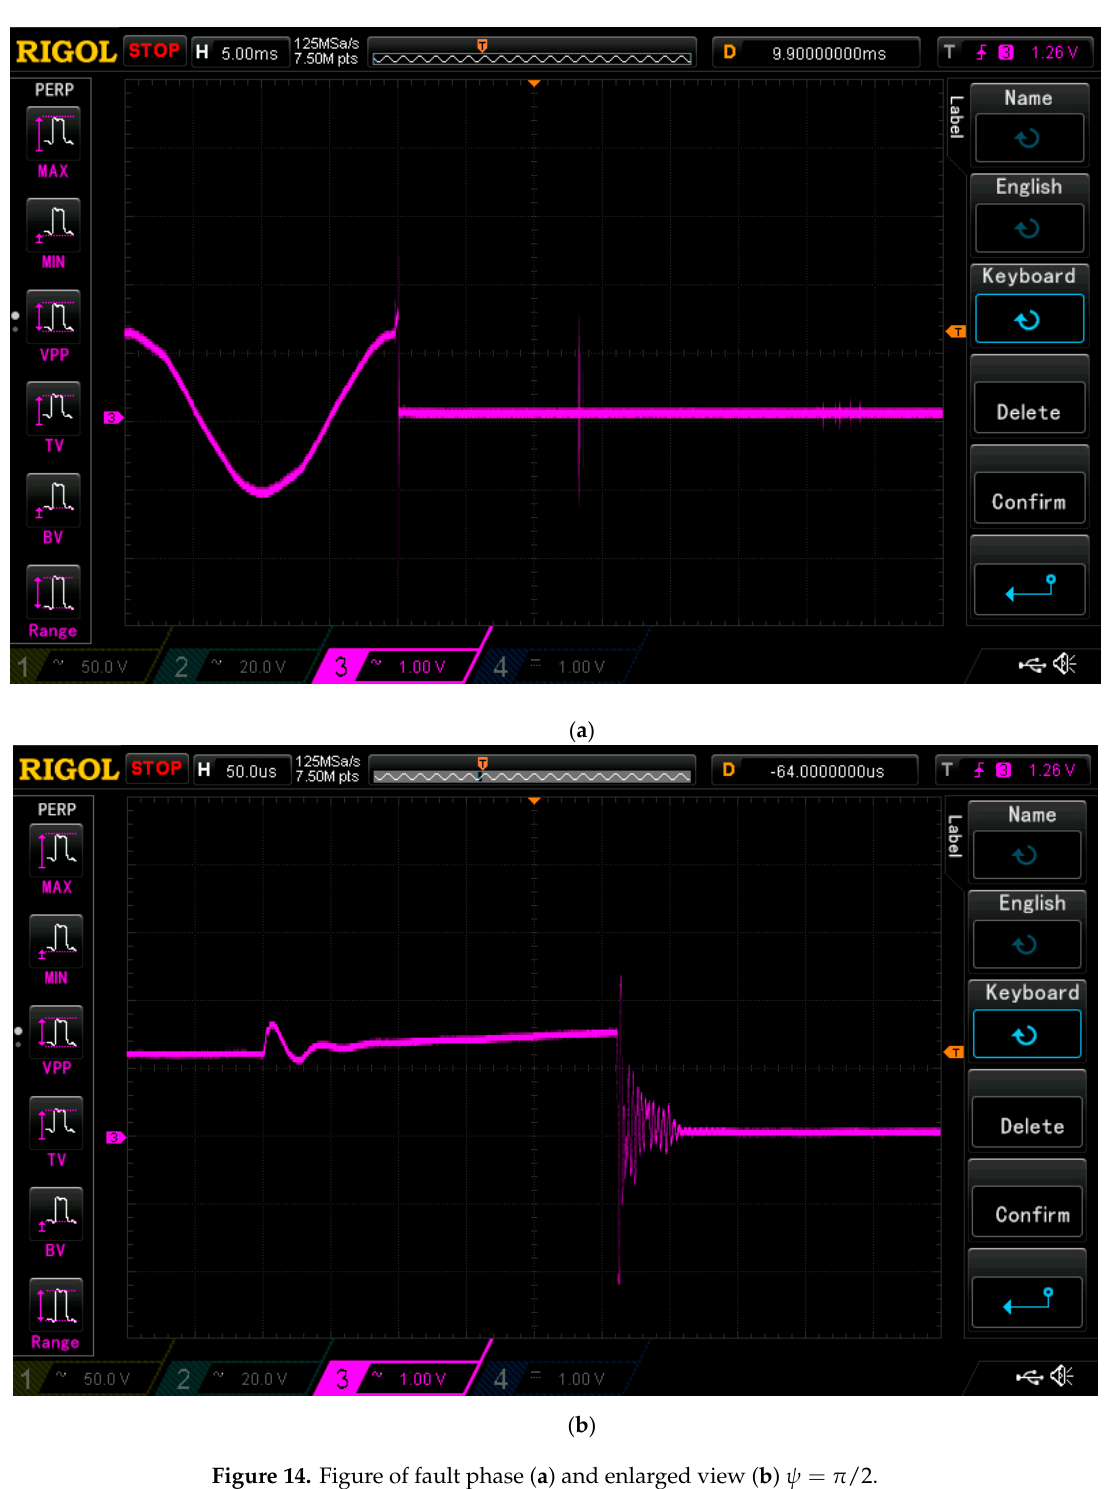
Figure 14. Figure of fault phase ( a ) and enlarged view ( b ) 2/ ψ = π